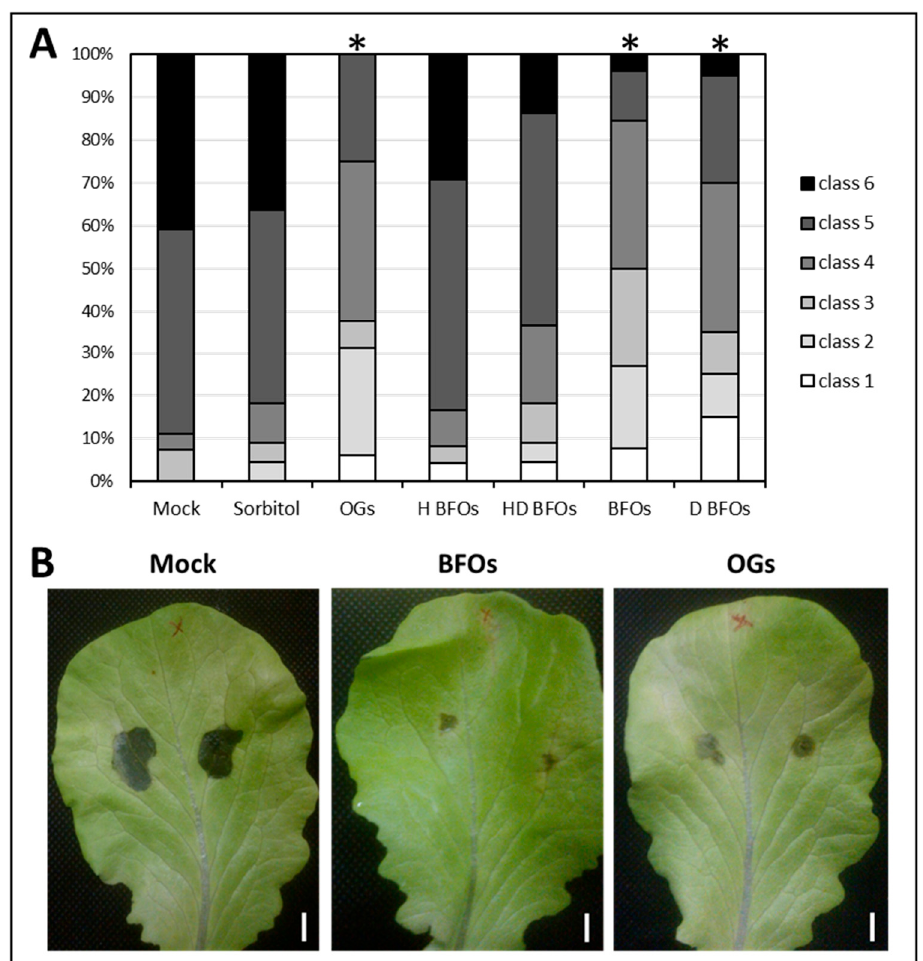
Figure 2. ( A ) Stacked-column chart illustrating severity class distribution resulting from the burdock fructooligosaccharides (BFOs) specificity test. Asterisks indicate significance against mock (water) at p < 0.01 according to non-parametrical, two-tailed, Mann–Whitney u -test, n ≥ 16. This experiment was repeated three times with consistent results; ( B ) Representative pictures of Botrytis lesions on lettuce leaves treated with water (mock), BFOs 5 g·L − 1 and oligogalacturonides (OGs) 0.5 g·L − 1 at 4 DPI (days post inoculation). Bars = 1 cm.